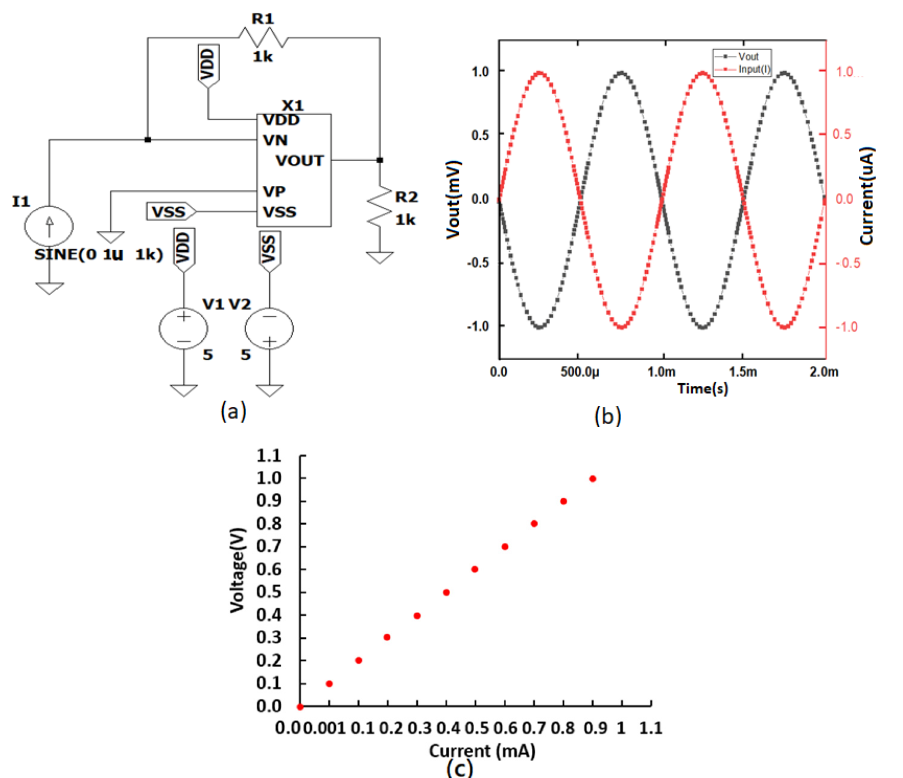
Figure 6. ( a ) Operational amplifier (OPA) as transimpedance amplifier ( b ) Simulation result ( c ) Simulation results showing the Linearity of TIA for 1 μ A to 1 mA input current.